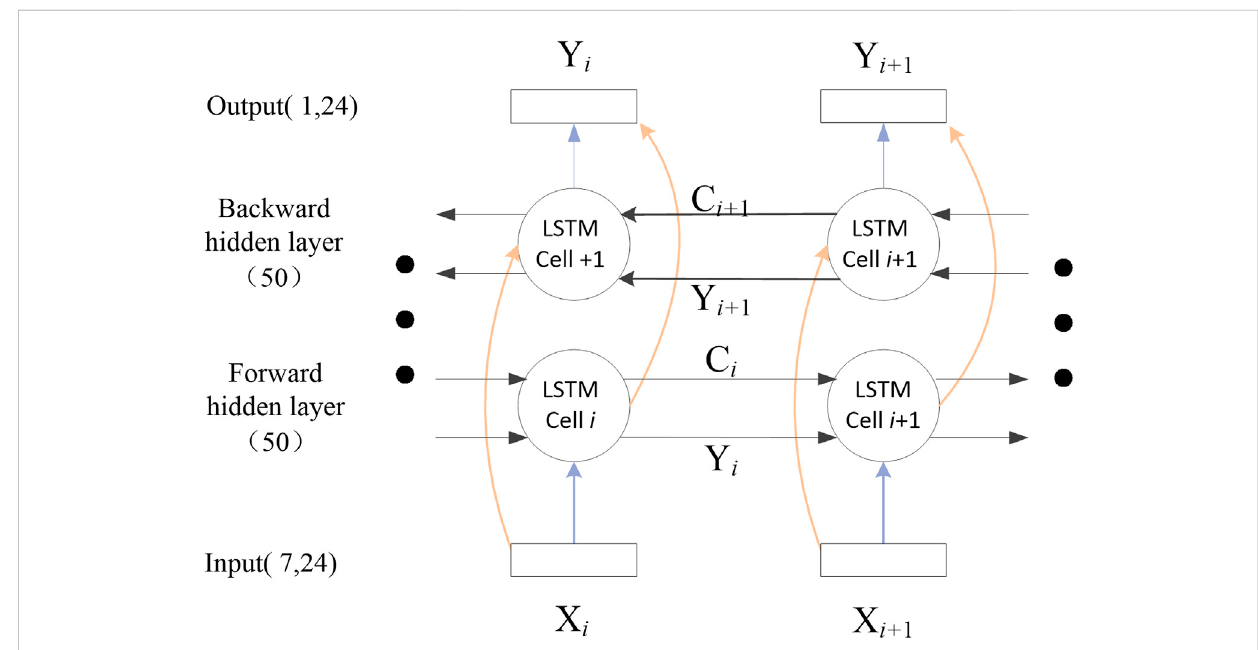
FIGURE 2 The structure diagram of Bidirectional long-term and short-term memory network.